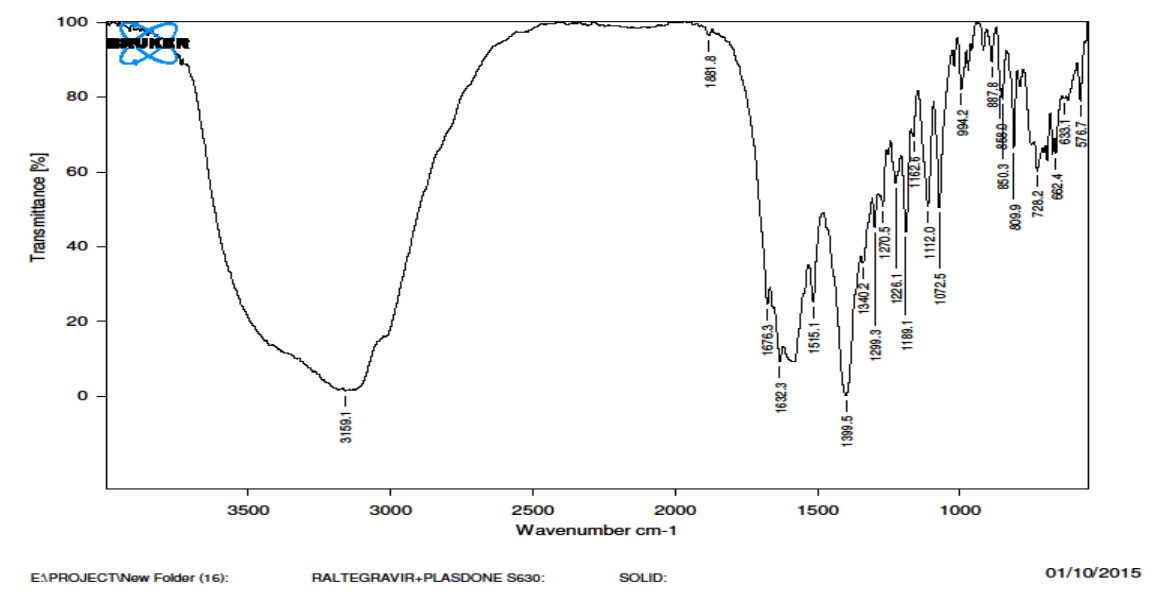
Figure 7.FTIR spectra of raltegravir and Plasdone S630 Differential scanning calorimetry